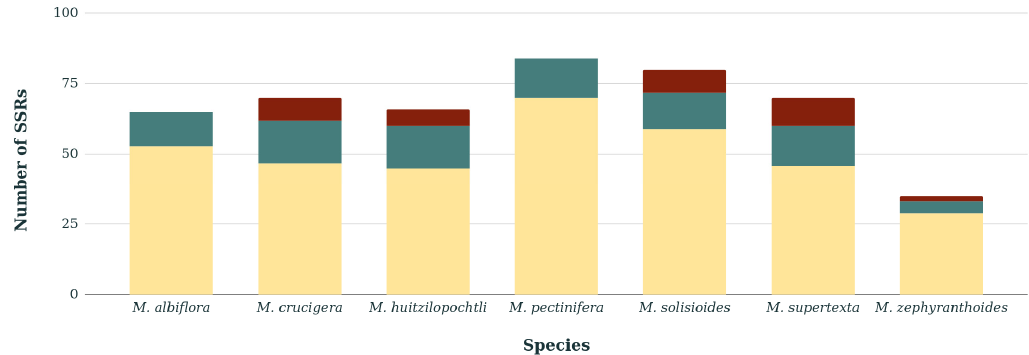
Figure 3. Total number of Short Sequence Repeats (SSRs) identified in the cpDNA of seven species of Mammillaria . The color of the bars corresponds to Inverted Repeats (red), Large Single Copy (yellow) and Small Single Copy